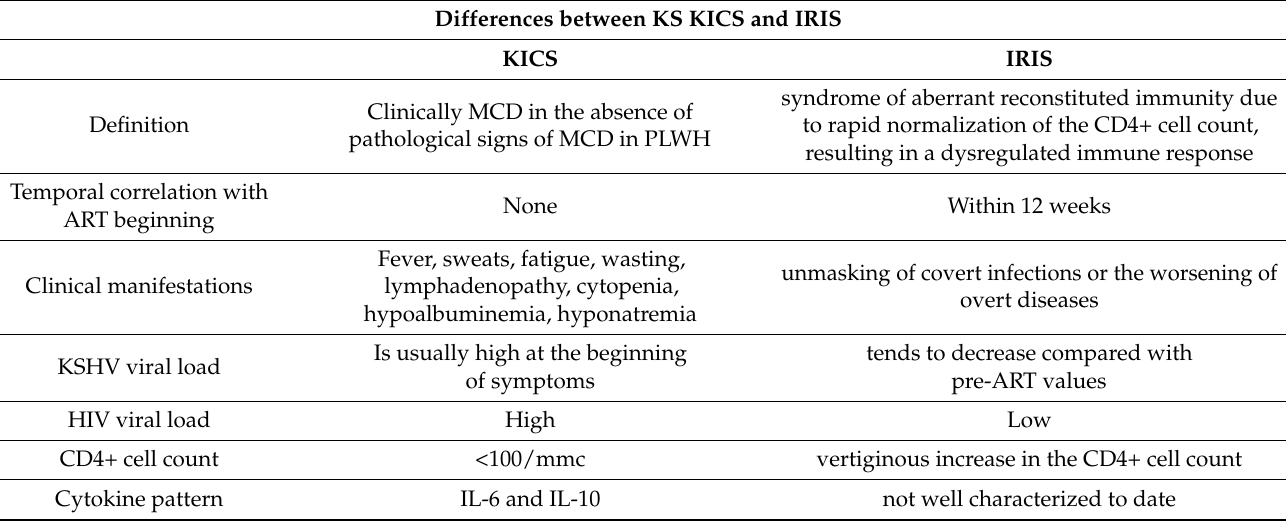
Table 2. Clinical and laboratory differences between KS KICS and IRIS in